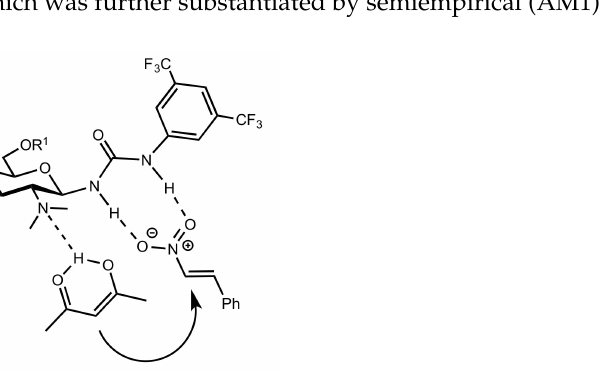
Figure 7. A proposed transition state explaining the stereoselectivity of the